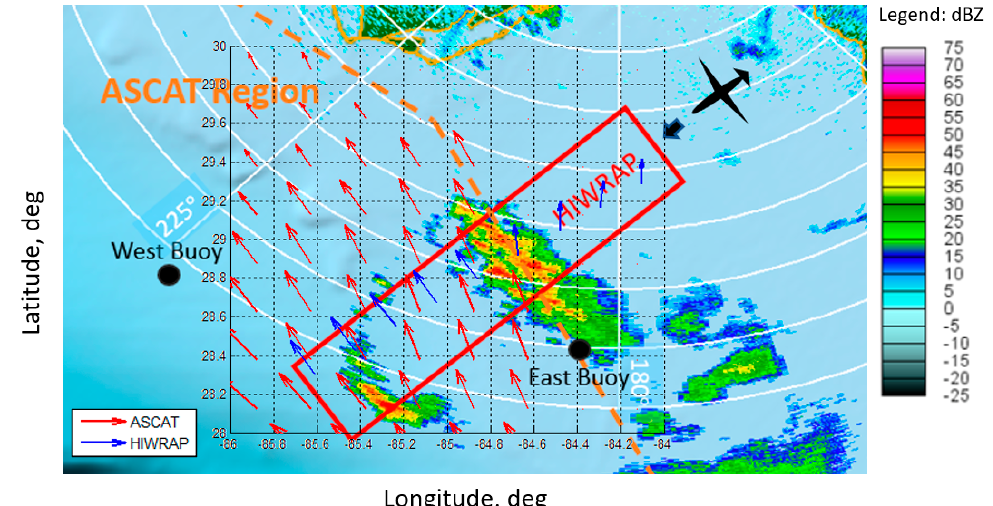
Figure 8. ASCAT and HIWRAP wind vectors superimposed on the NEXRAD reflectivity image. The red box indicates the HIWRAP swath, where the wind magnitude and direction change as the aircraft passes over the squall line. Buoys are indicated by large black dots.